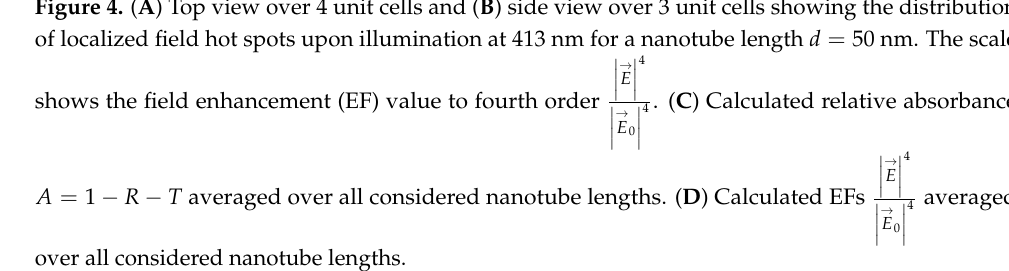
over all considered nanotube